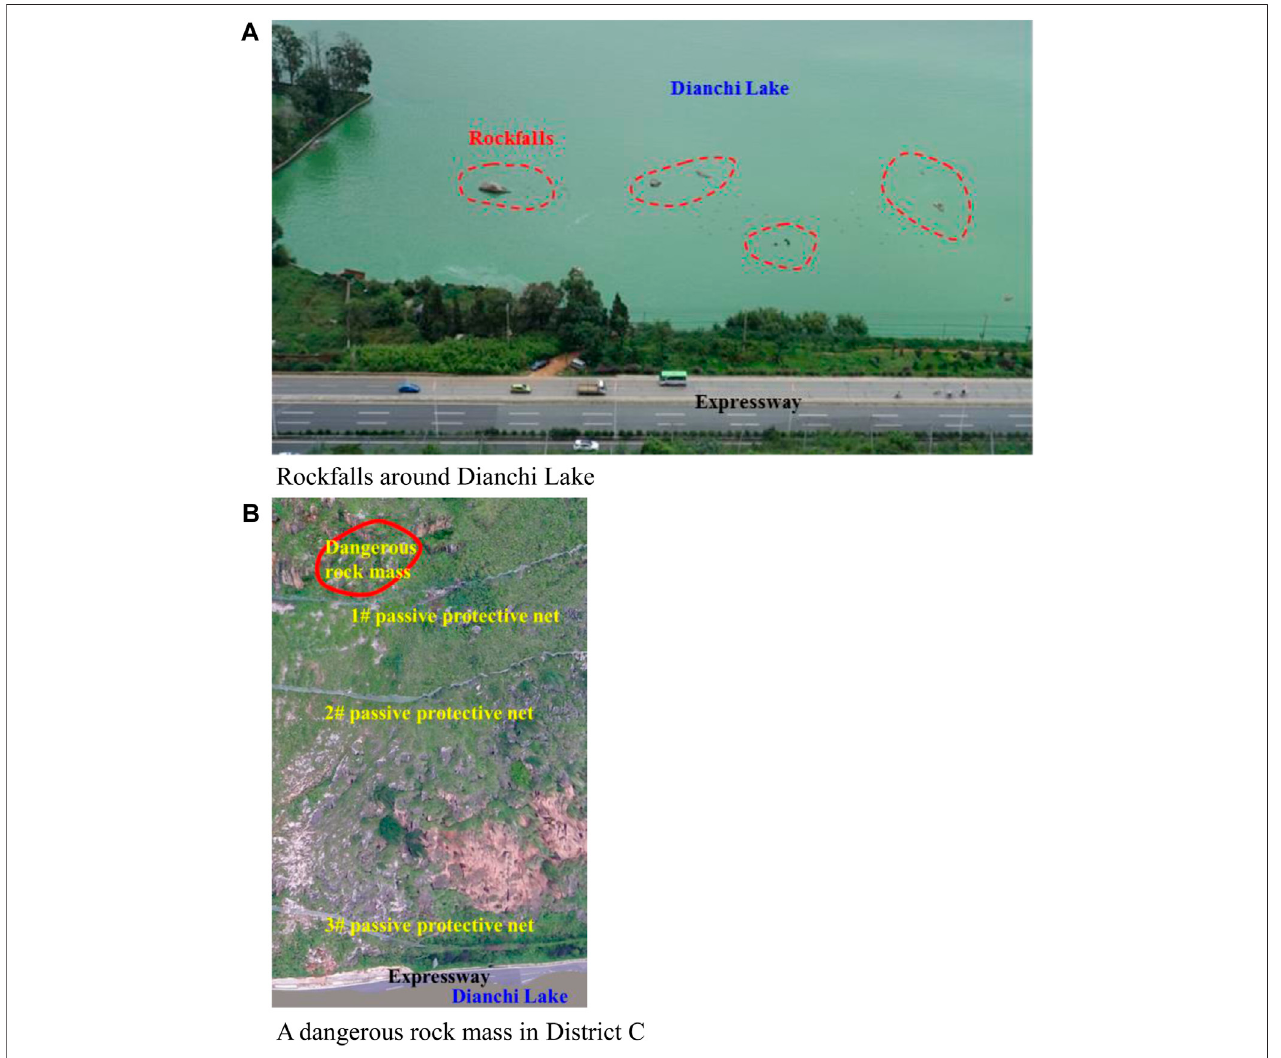
FIGURE 10 | (A) Rockfalls around Dianchi Lake. (B) A dangerous rock mass in District C fi eld investigation of the rockfall used as a case study.